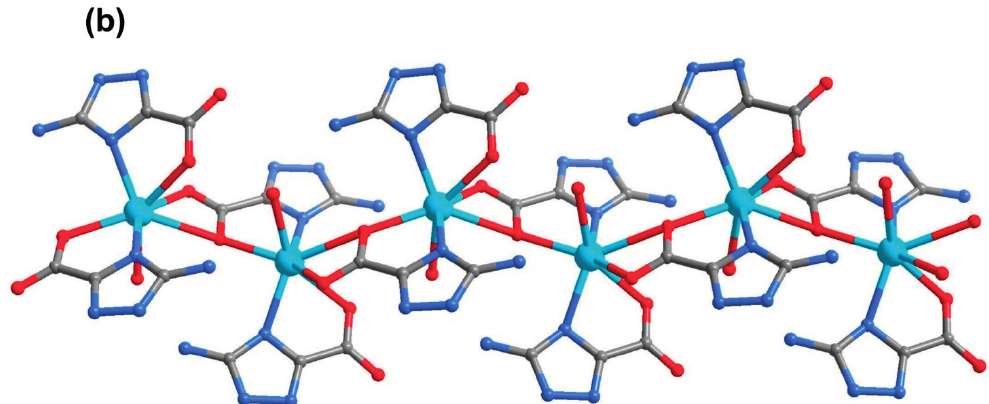
Figure 7. Schematic representation of the ( a ) Cd 2+ coordination environment present in compound [Cd(Hatrc) 2 (H 2 O)] n ( 4 ) showing the labeling scheme for all non-hydrogen atoms composing the asu and the Cd1 coordination environment. Non-H atoms of the asu are represented as thermal ellipsoids drawn at the 70% probability level and the remaining atoms as spheres with arbitrary radii; ( b ) 1D coordination chain present in compound 4 . For selected bond lengths (in Å) and angles (in degrees) see Table 3. Symmetry operation: m = 1.5 − x , y+0.5 , 0.5 − z.